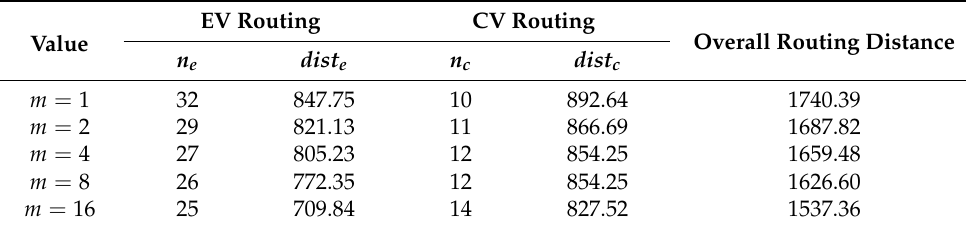
Table 5. Results for large-size instance c101_21 with various m